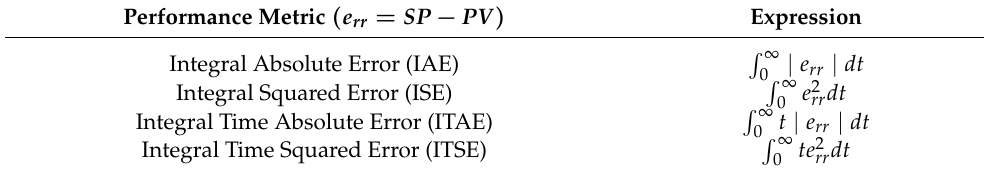
Table 5. Performance metric of the